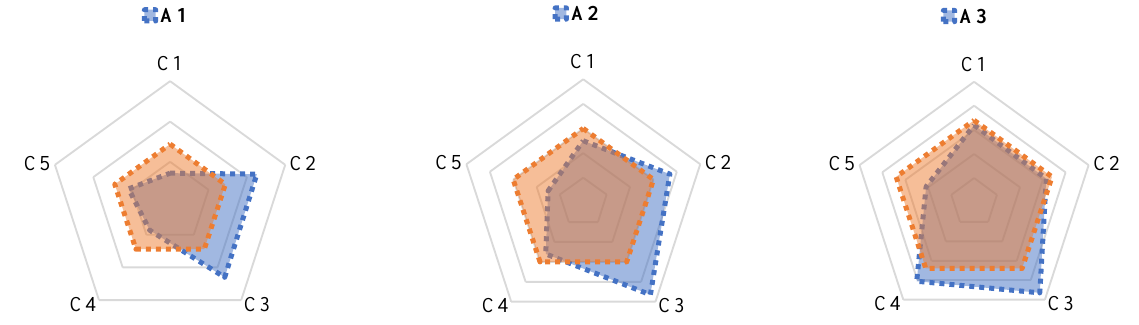
Figure 4. The variation in each alternative in the weighted normalized decision matrix, where 𝐴 1 , 𝐴 2 , and 𝐴 3 are the alternatives.